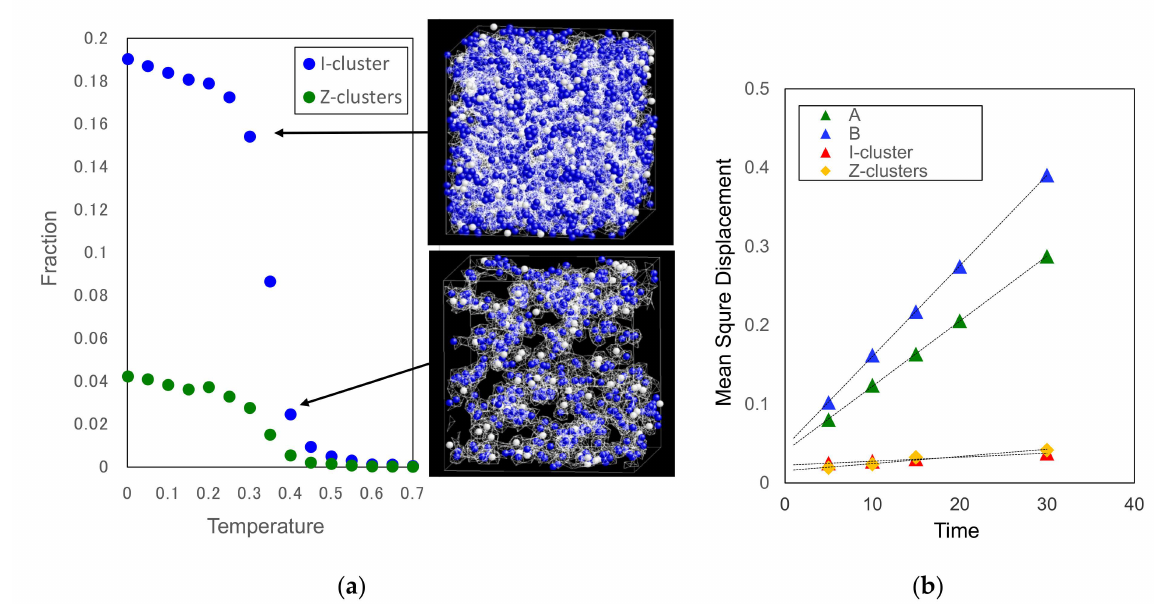
Figure 3. ( a ) Temperature dependence of the population of I- and Z-clusters in a middle-cooling process of the r BB = 0.8 A 50 B 50 alloy system. The insets show the spatial distribution of I- and Z-clusters at T = 0.3 (upper) and T = 0.4 (lower), where the central atoms of the I- and Z-clusters are depicted by the blue and white spheres, respec- tively. ( b ) Time evolution of mean square displacements of the A atoms (green), B atoms (blue), the central atoms of I-clusters (red), and those of Z-clusters (yellow) in a supercooled liquid phase of the same system annealed at T =